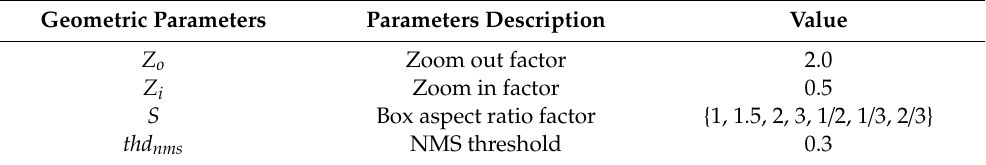
Table 3. Geometric parameters of